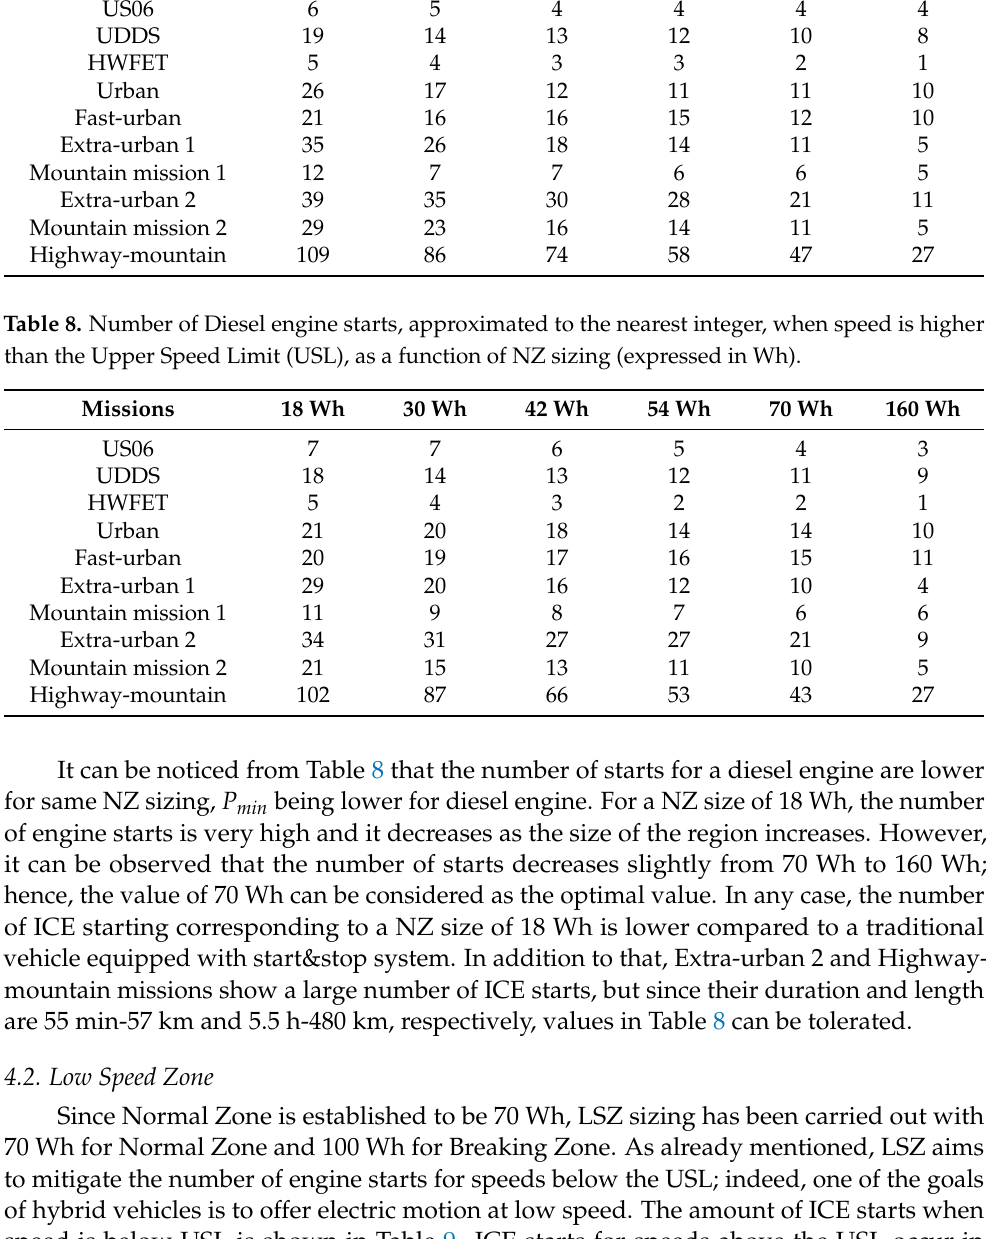
Table 7. Number of Spark-ignition engine starts, approximated to the nearest integer, when speed is higher than the Upper Speed Limit (USL), as a function of NZ sizing (expressed in Wh). Missions 18 Wh